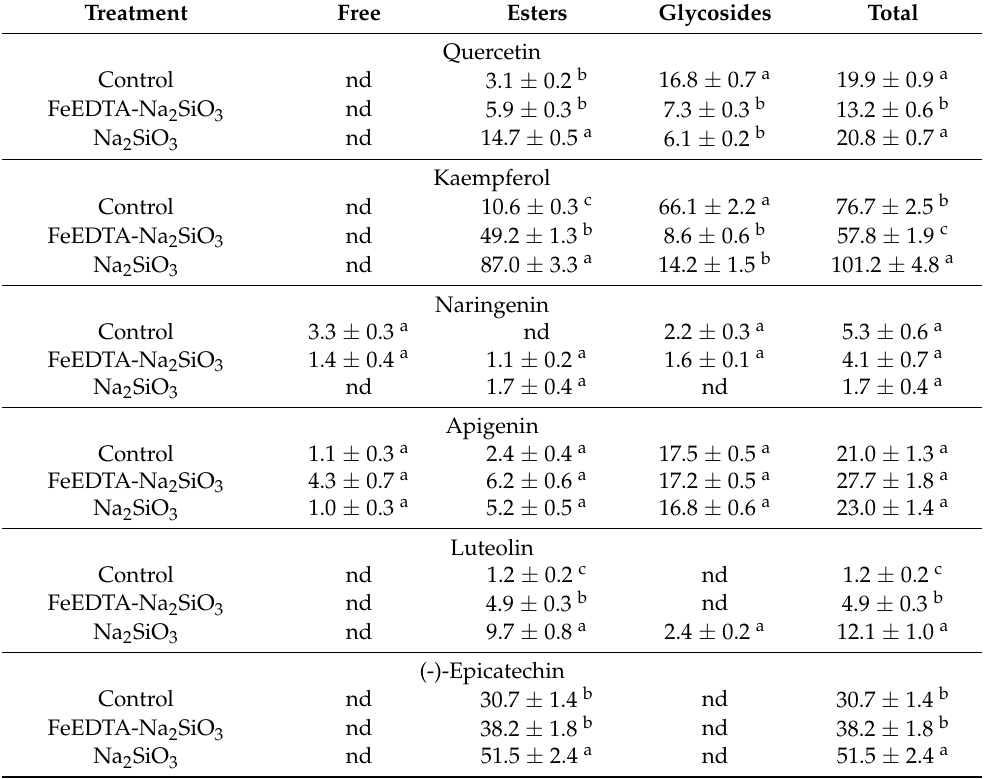
in total) in radish sprouts treated with elicitors during